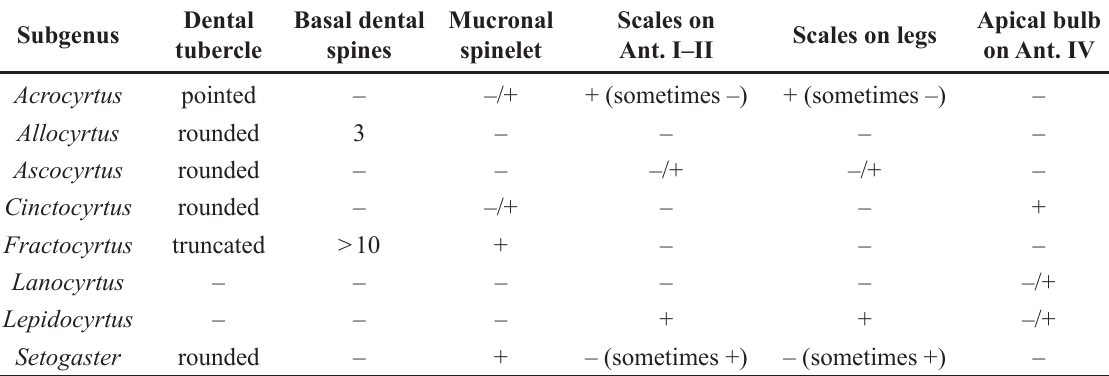
Table 1. Main differences to separate the eight subgenera (Cipola et al. 2018) of Lepidocyrtus Bourlet, 1839 s. lat.: Acrocyrtus Yosii, 1959 (= Carocyrtus Yoshii & Suhardjono, 1989 and Onerocyrtus Yoshii &